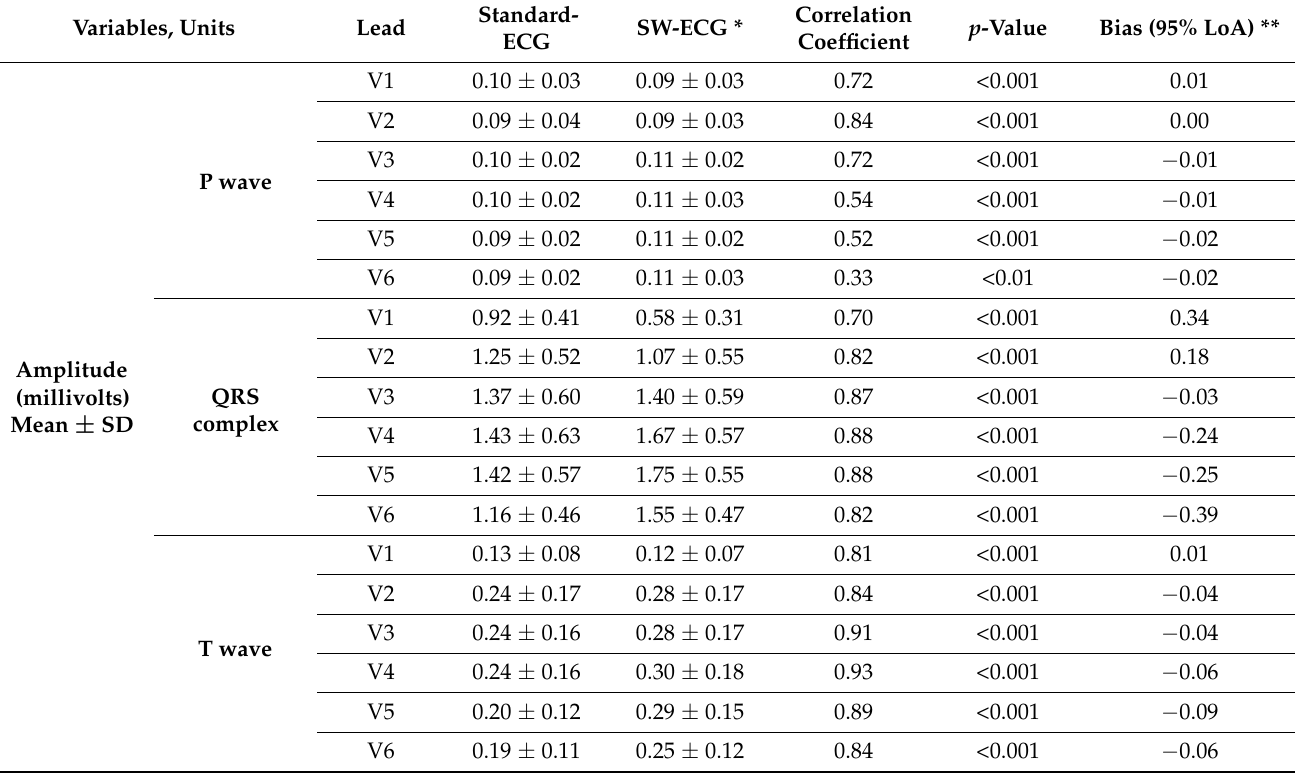
Table 2. Electrocardiogram (ECG) characteristics